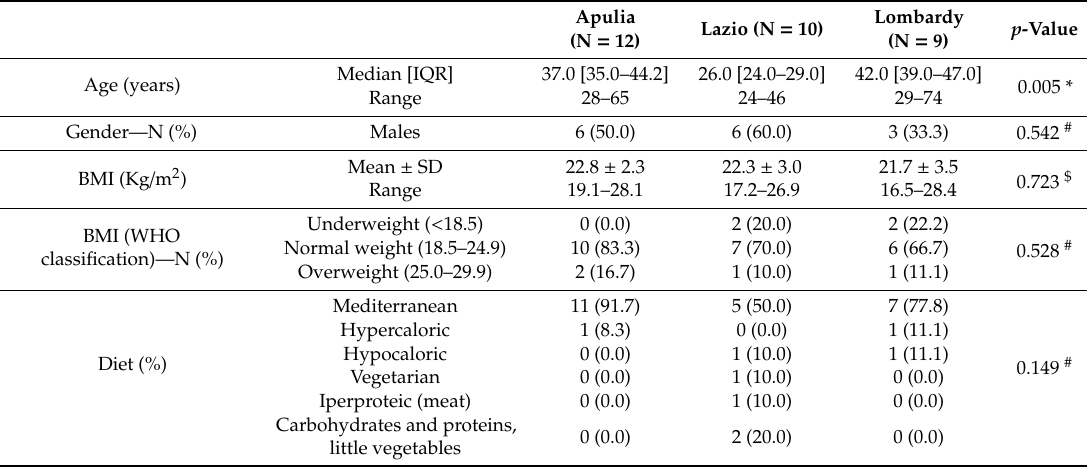
Table 1. Subjects’ demographic and behavioral characteristics by Italian